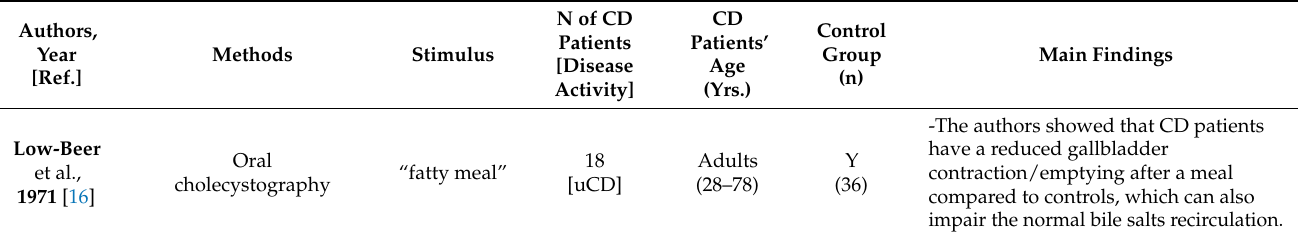
Table 1. Summary of the main characteristics and findings of clinical studies investigating gallbladder functioning and regulation in CD